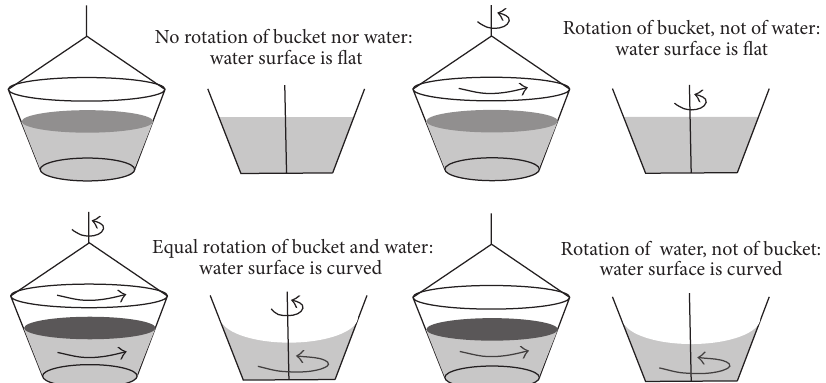
Figure 1: Newton’s water bucket thought experiment, proving—to Newton—the existence of absolute space, as acting medium. The water shape only changes when the water is rotating relative to absolute space and is not influenced by the rotation state relative to the bucket.